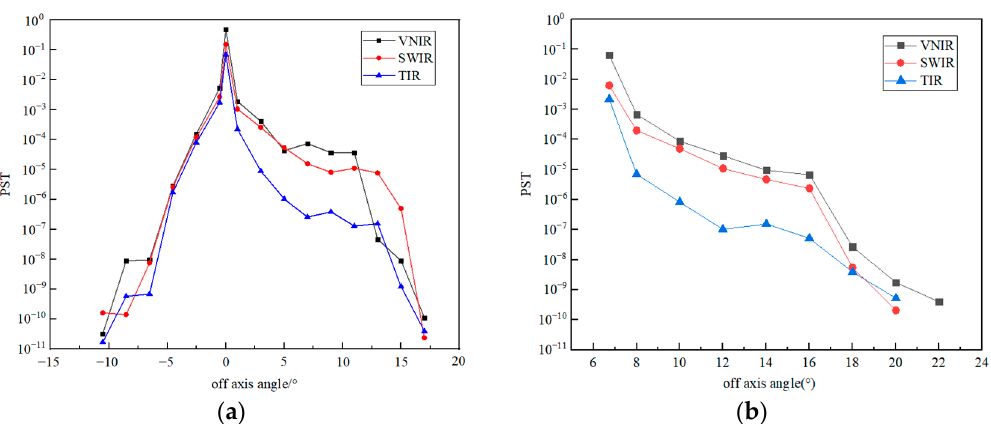
Figure 9. PST curves of VNIR, SWIR, and TIR channels. ( a ) Y direction; ( b ) X direction .